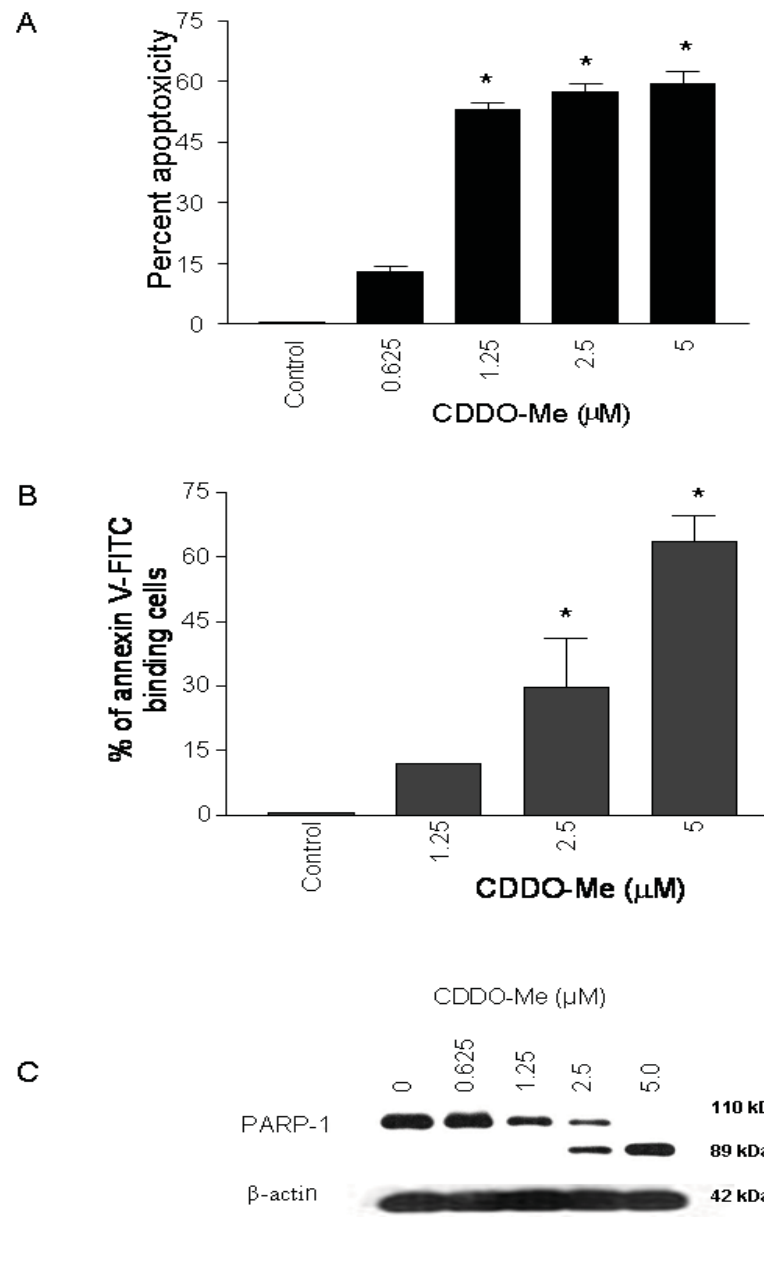
Figure 1. CDDO-Me inhibits growth and induces apoptosis in TRAMPC-1 prostate cancer cells. (A) . Effect on cell viability . 1 × 10 4 TRAMPC-1 cells were treated with CDDO-Me at concentrations ranging from 0 to 5 μM for 72 h in triplicate in 96-well microtiter plate. Cell viability was measured by MTS assay using CellTiter AQueous assay system from Promega and from decrease in viability cytotoxicity (apoptoxicity) was determined; (B) & (C) . CDDO-Me induces apoptosis in TRAMPC-1 cells. TRAMPC-1 cells were treated with CDDO-Me for 24 h at concentrations as shown and binding of annexin V-FITC (B) and cleavage of PARP-1 (C) was measured by flow cytometry and western blotting, respectively. * Significantly different from control ( P <